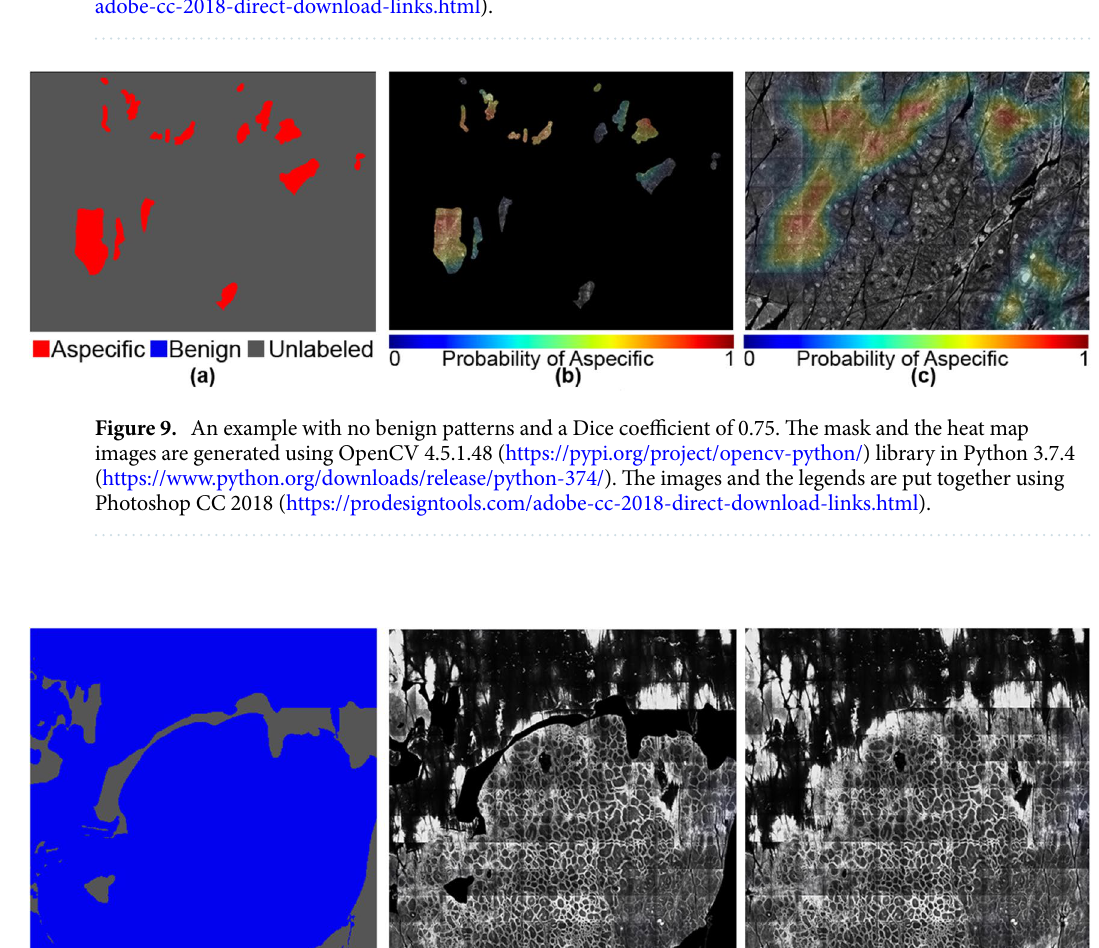
Figure 8. An example with a majority unlabeled or aspecific patterns with an AUC of 0.646 and a Dice coefficient of 0.45. The mask and the heat map images are generated using OpenCV 4.5.1.48 (https ://pypi.org/ proje ct/openc v-pytho n/) and the ROC curve is generated using matplotlib 3.3.3 libraries (https ://matpl otlib .org/ users /insta lling .html) in Python 3.7.4 (https ://www.pytho n.org/downl oads/relea se/pytho n-374/). The images and the plot, together with the legends are put together using Photoshop CC 2018 (https ://prode signt ools.com/ adobe -cc-2018-direc t-downl oad-links .html).